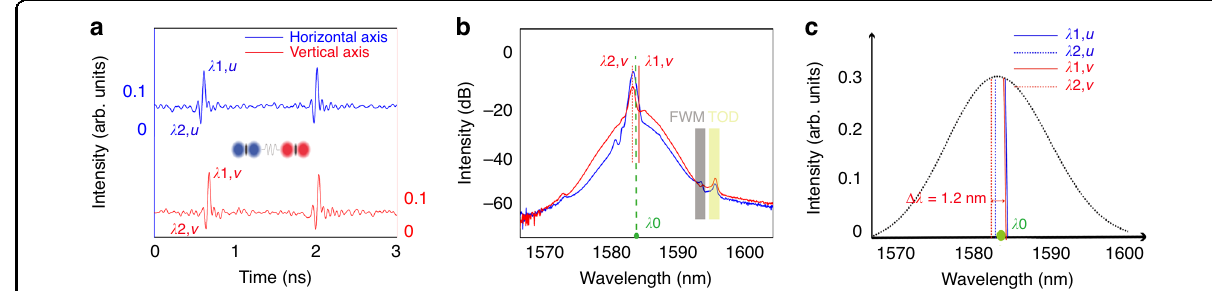
Fig. 7 Formation of (2 + 2) PSMs. a A state of (2 + 2) PSMs. Blue solid line and red solid line: polarization-resolved laser emissions. b Optical spectra of ( a ). c Schematic illustration of the central wavelengths of the vector BSs and DSs with respect of the ZGVD point, λ 0 : the position of ZGVD point, λ 1, u : central wavelength of BSs formed along the horizontal polarization axis, polarization axis, λ